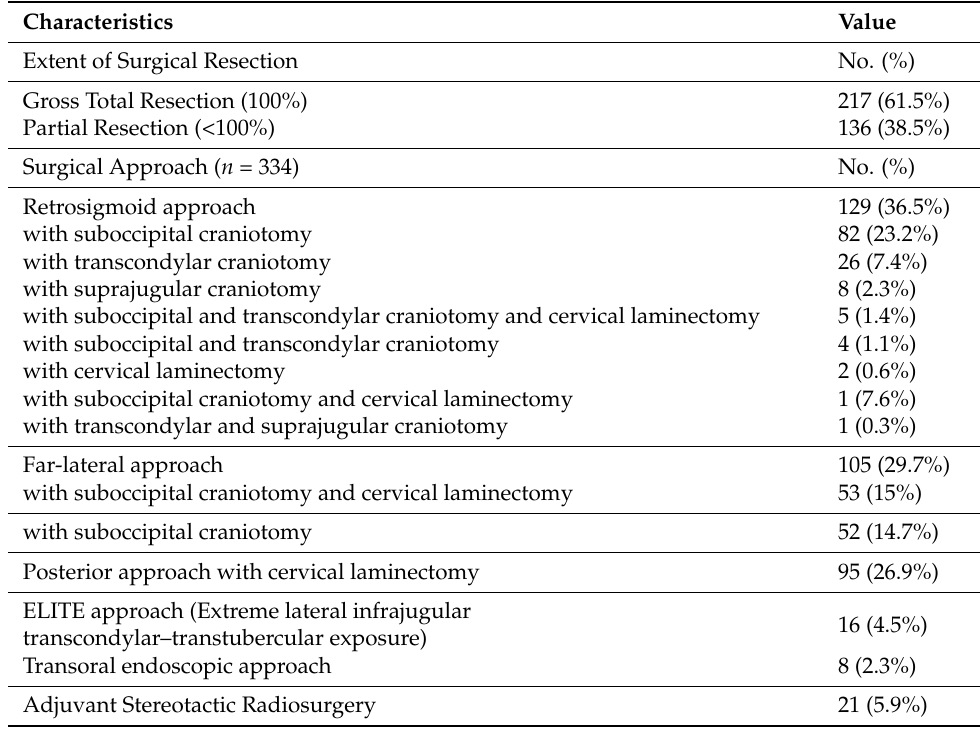
Table 3. Summary of management strategies.